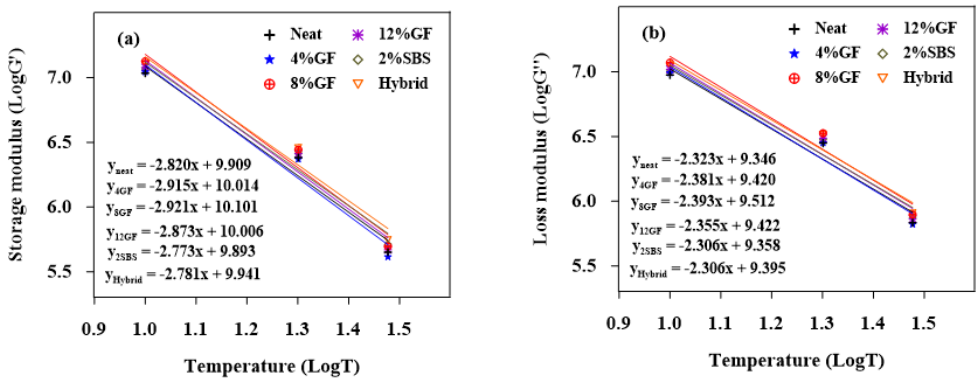
Figure 5. Sensitivity of PAV binders to temperature for ( a ) G (cid:48) and ( b ) G (cid:48)(cid:48)